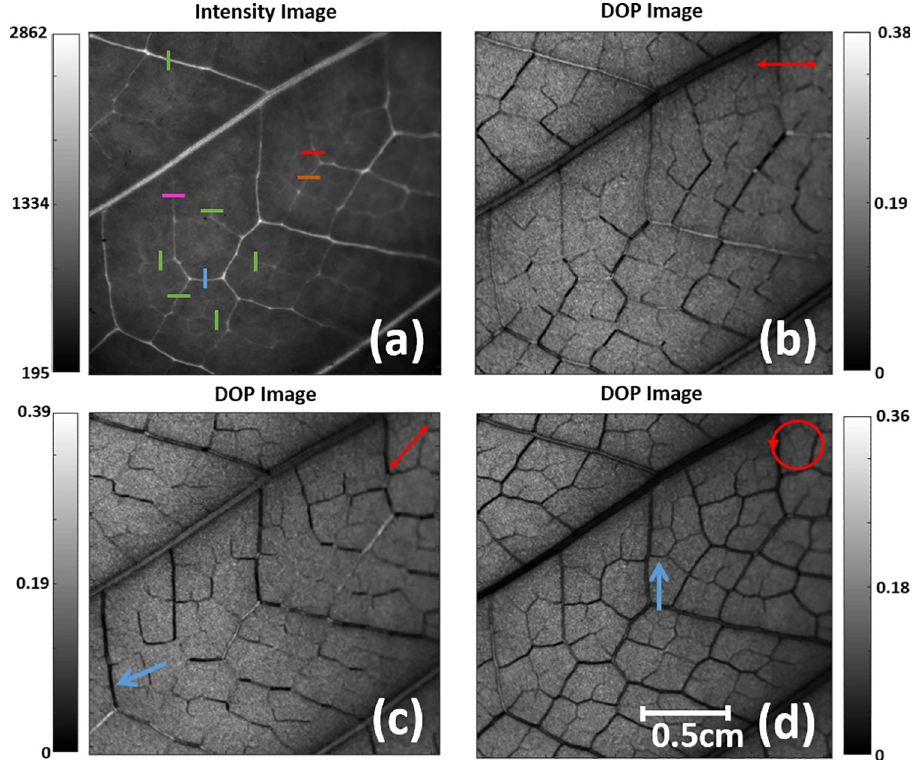
Fig 3. (a) Nonpolarized light intensity image of the Hedera maroccana (Sample A) obtained on transmission. (b)-(d) DoP image for an input polarization: (b) linear polarization at 0˚; (c) linear polarization at 45˚; (d) left-handed circular polarization. Input polarization is marked in red at the top-right corner of the